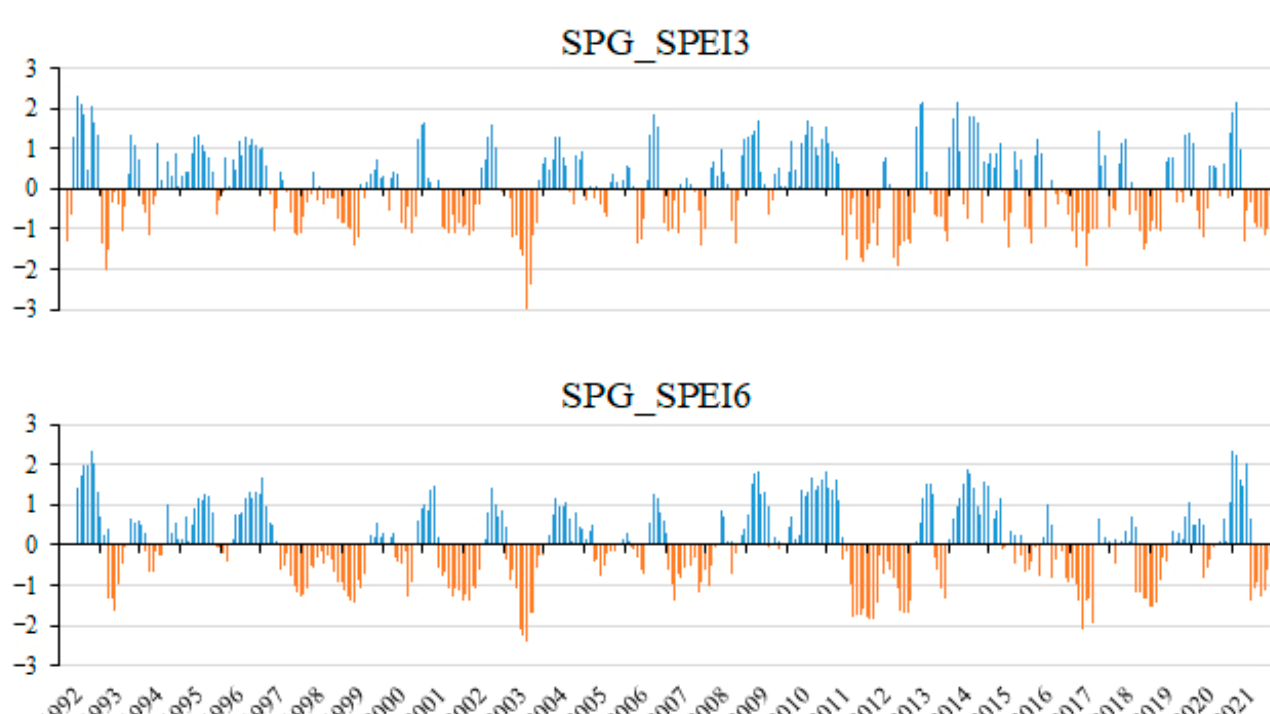
Figure 3. Long-term standardized precipitation-evapotranspiration index (SPEI) calculated at SPG on 3- and 6-month basis. For each year, blue and red bars represent, respectively, monthly positive and negative SPEI values.